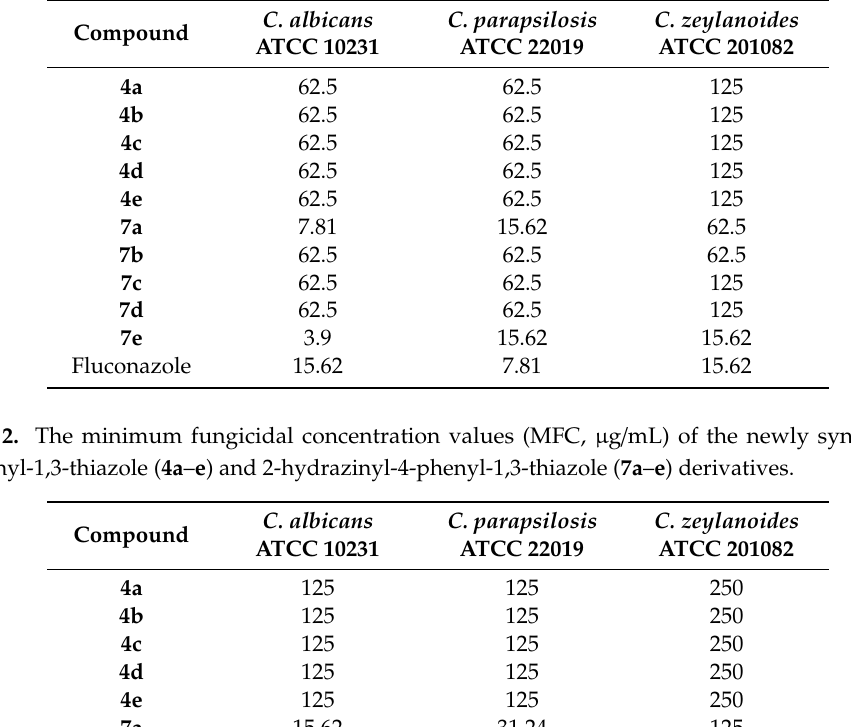
Table 1. The minimum inhibitory concentration values (MIC, µ g / mL) of the newly synthesized